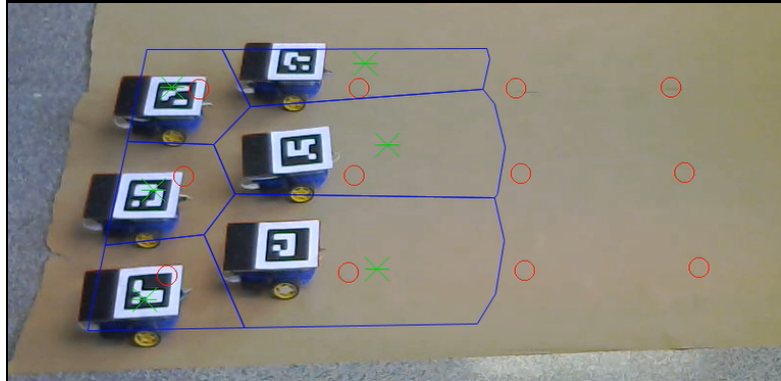
Figure 19. Initial configuration of the experiment